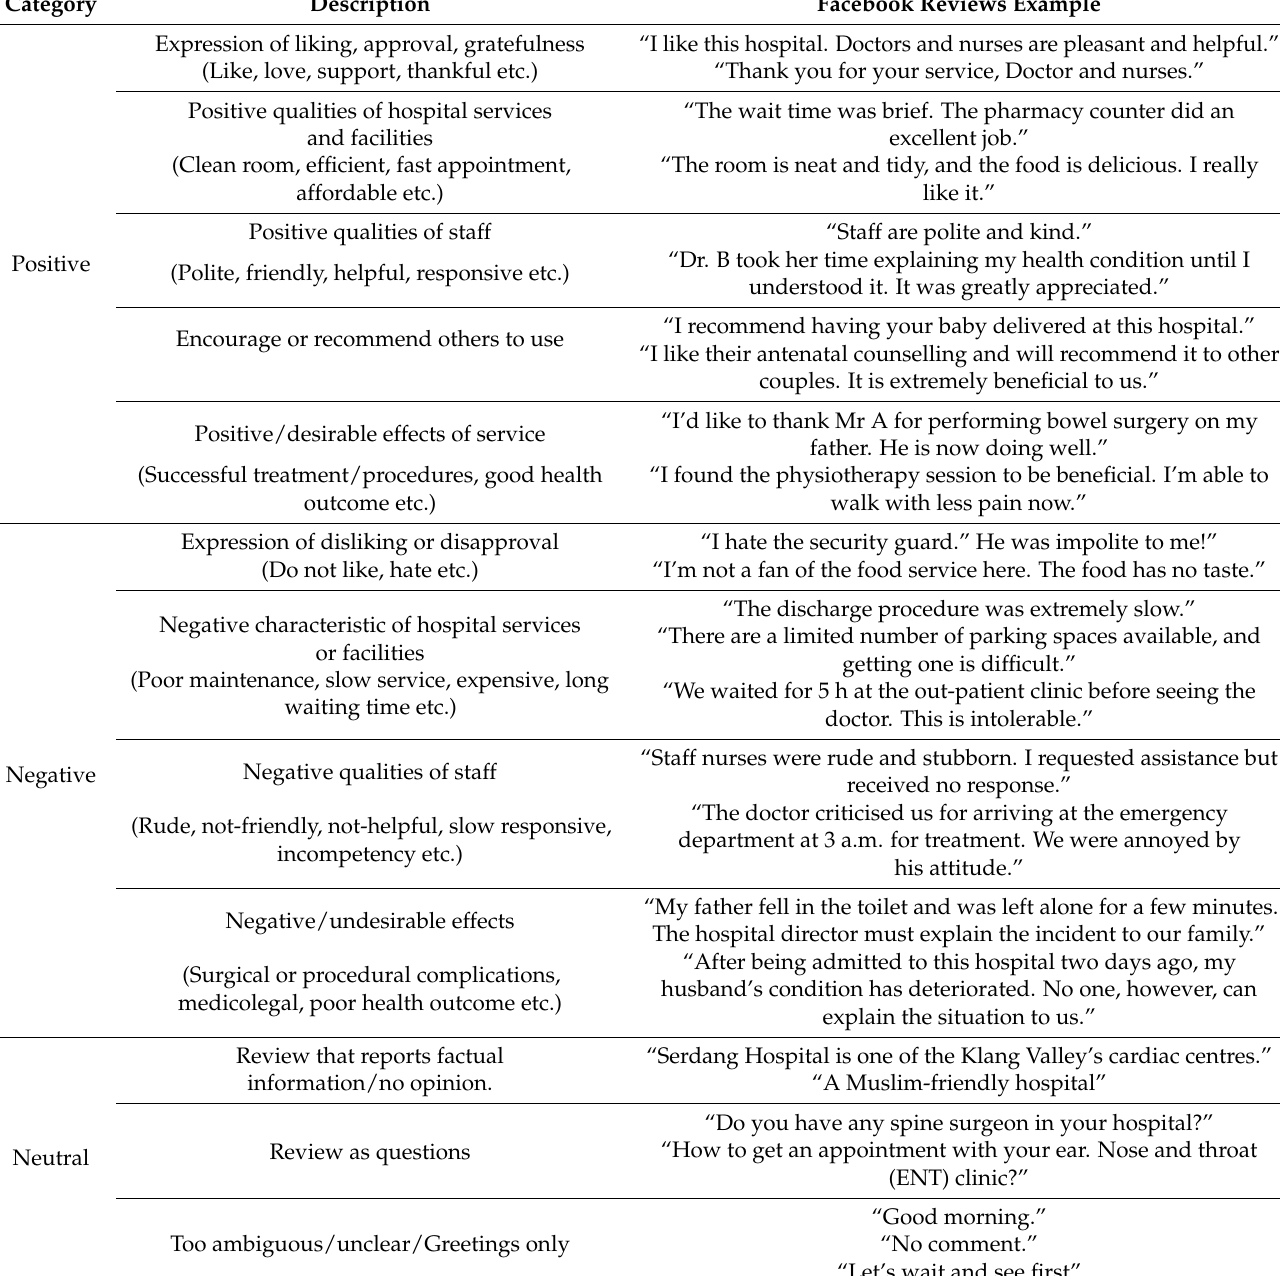
Table A2. Sentiment Analysis